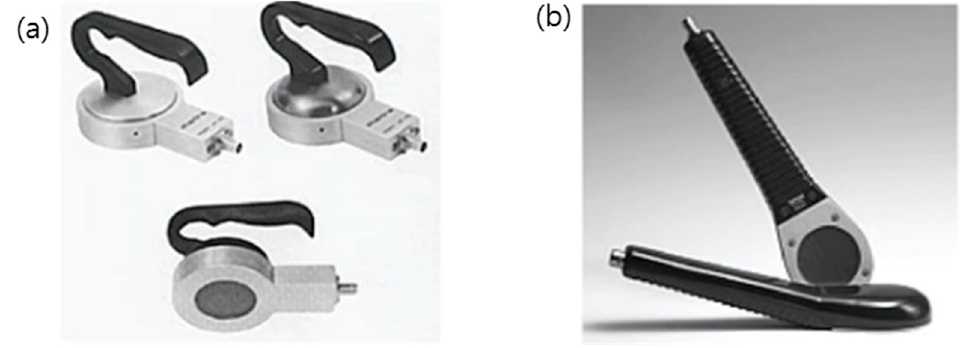
Figure 14. HP-210/HP-360 series pancake Geiger-Mueller detectors: ( a ) HP-210 [78], ( b ) HP-360 [79].